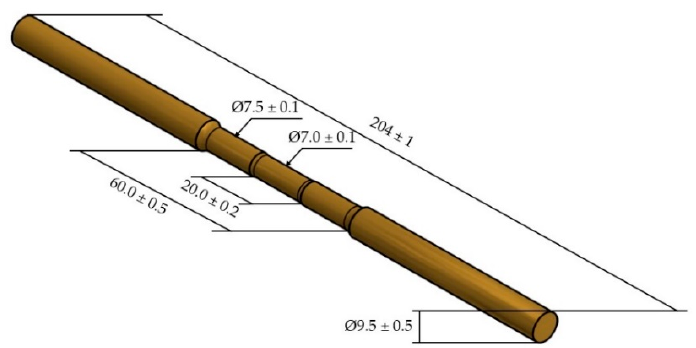
Figure 2. Specimen for the measurement of the mechanical property tests with the values in millimeters.